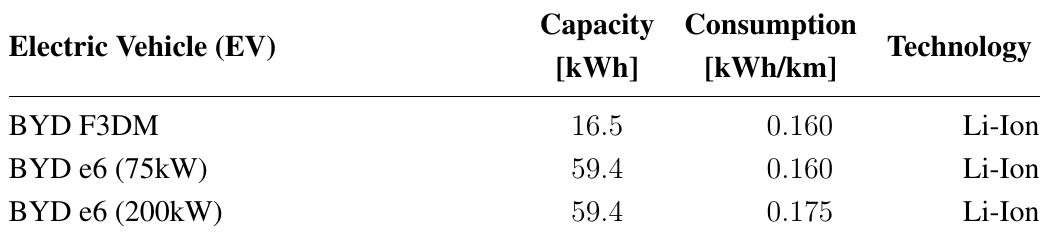
Table 1. EV and Plug-in Hybrid EV Models, Battery Type and Capacity, and